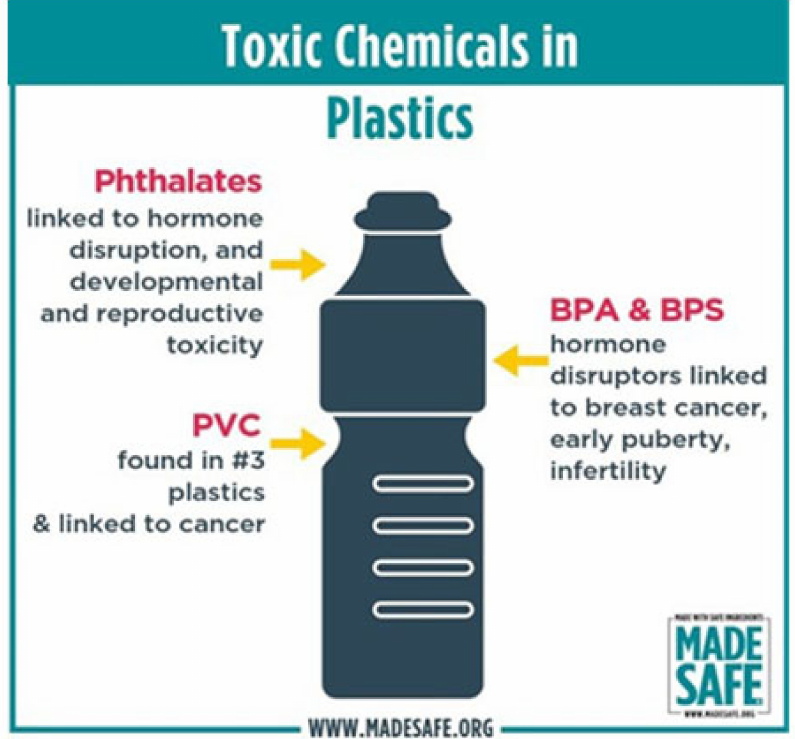
Figure 16. Some of the chemical toxic contaminants from plastics involving the animal and human health (by the courtesy of